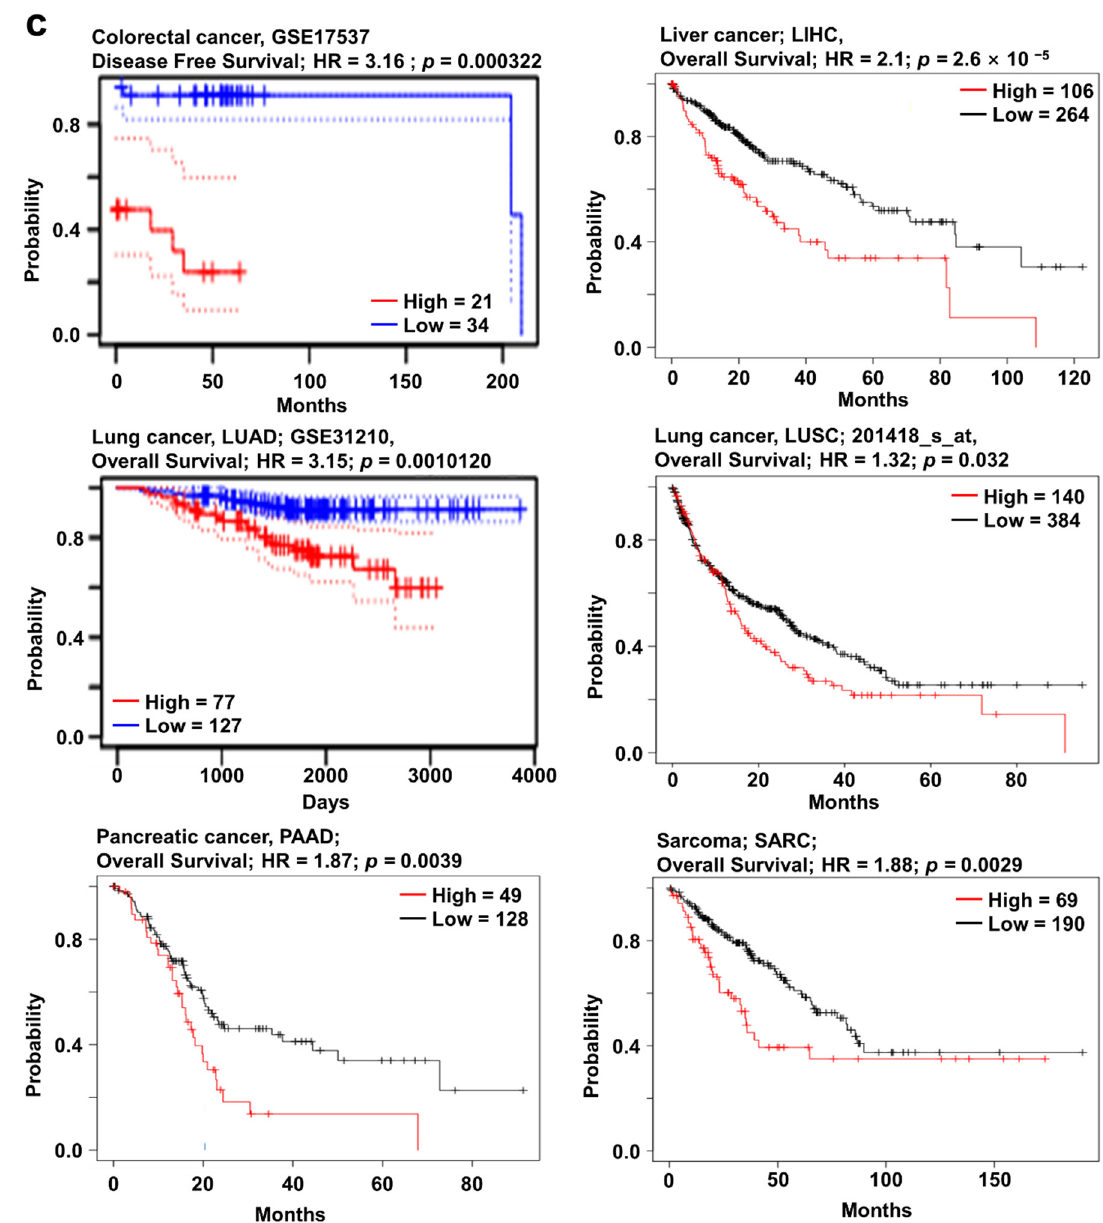
Figure 2. SOX4 expression pattern and patient survival in various cancers. SOX4 expression, alteration frequency of mutations, copy number alteration, and correlation with patient survival in various types of cancer. ( a ) Box plots comparing SOX4 expression in normal (left plot) and cancer tissues (right plot) were derived from the Oncomine database. The fold-changes in SOX4 expression in colon, lung, liver, and pancreatic cancers, as well as sarcoma are shown as box plots. ( b ) The mutations and alteration frequency of SOX4 were determined using the cBioPortal database. The diagram shows SOX4 mutation in different cancer types across protein domains. The alteration frequency of SOX4 was retrieved using cBioPortal and is shown at the bottom. Only those cancer types with more than 100 samples and an alteration frequency of over 3.7% are shown. The alterations comprised deletions (blue), amplification (red), or mutation (green). ( c ) The survival plot comparing patients with high (red) and low (blue) expression in various cancer types was plotted using the Kaplan–Meier plotter, PrognoScan, and R2 databases. Survival plot analysis was performed using a threshold Cox p -value of <0.05. Abbreviations. CRC: colorectal cancer; LIHC: liver hepatocellular carcinoma; LUAD: lung adenocarcinoma; LUSC: lung squamous cell carcinoma; PAAD: pancreatic adenocarcinoma; AT: adipose tissue; PLS: pleomorphic liposarcoma.